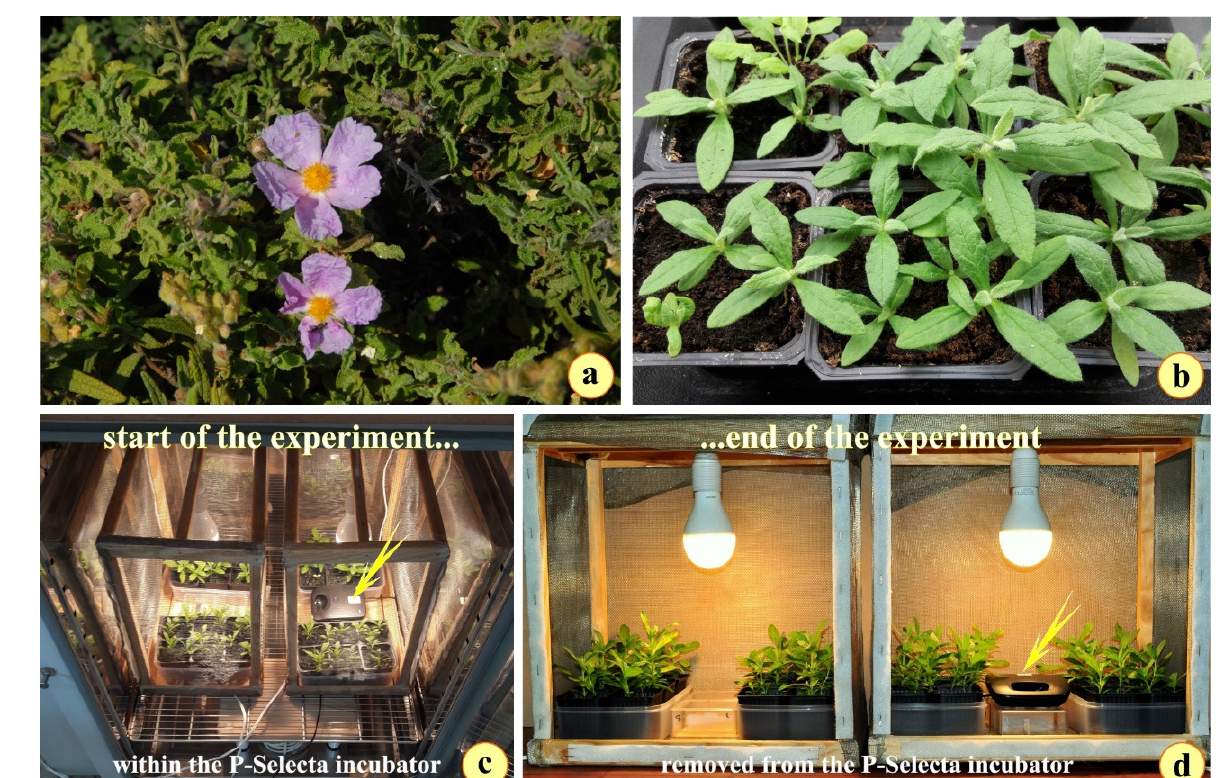
Figure 1. ( a ) A wild-growing individual of Cistus creticus . ( b ) The plastic pots with the young plants, ready for incubation. ( c ) The two cages accommodated within the P-Selecta incubator at the beginning of the experiment. ( d ) The two cages removed from the incubator at the end of the experiment, after seven weeks. The left cage contains the irradiated plants. The yellow arrow points at the DECT base unit.